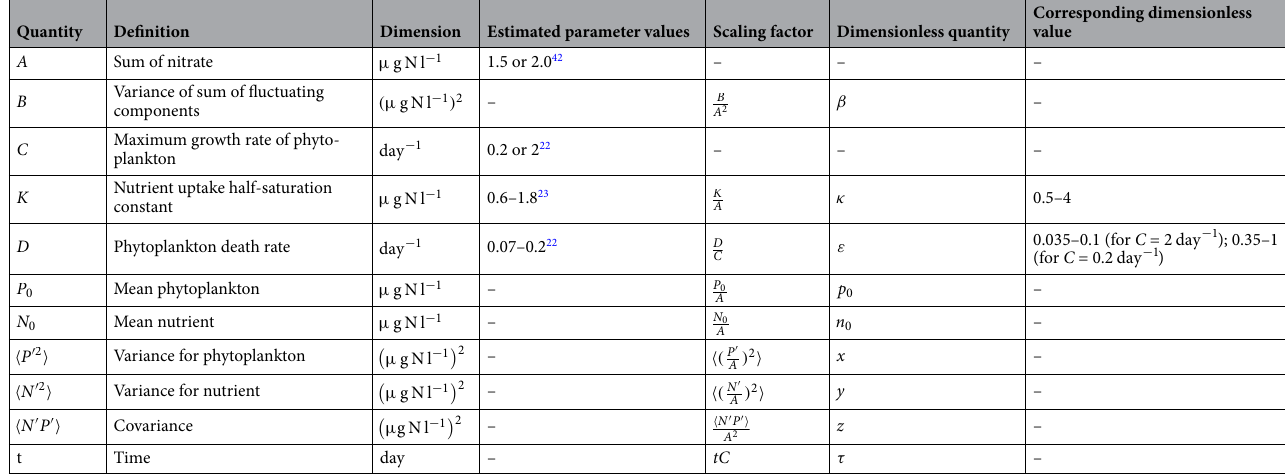
Table 3. Definition of different quantities (parameters) used in the model, their dimensions and estimated